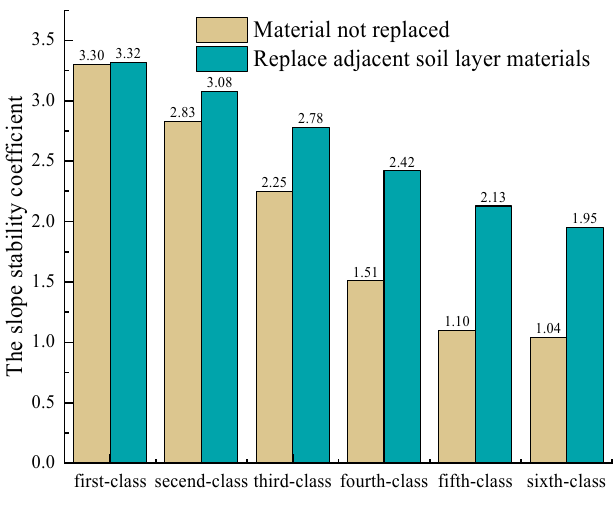
Figure 8. Comparison of the mining face of slope collapse.